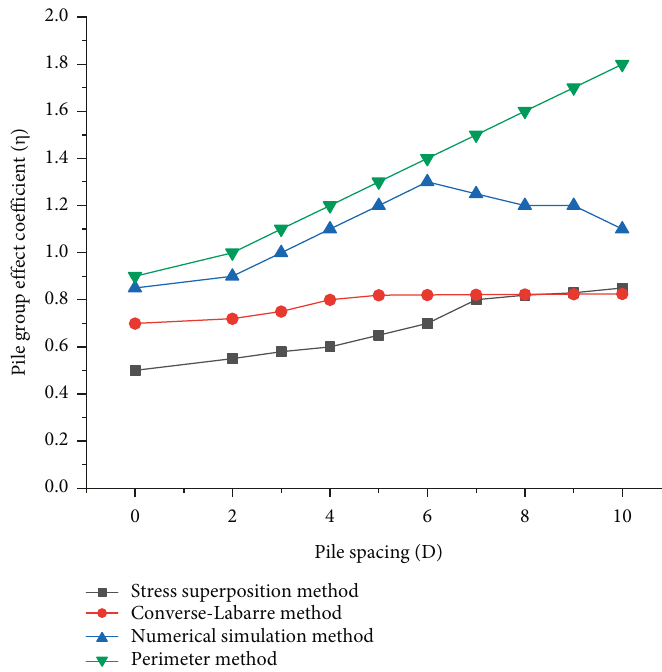
Figure 20: Comparison diagram of pile group effect coefficient.